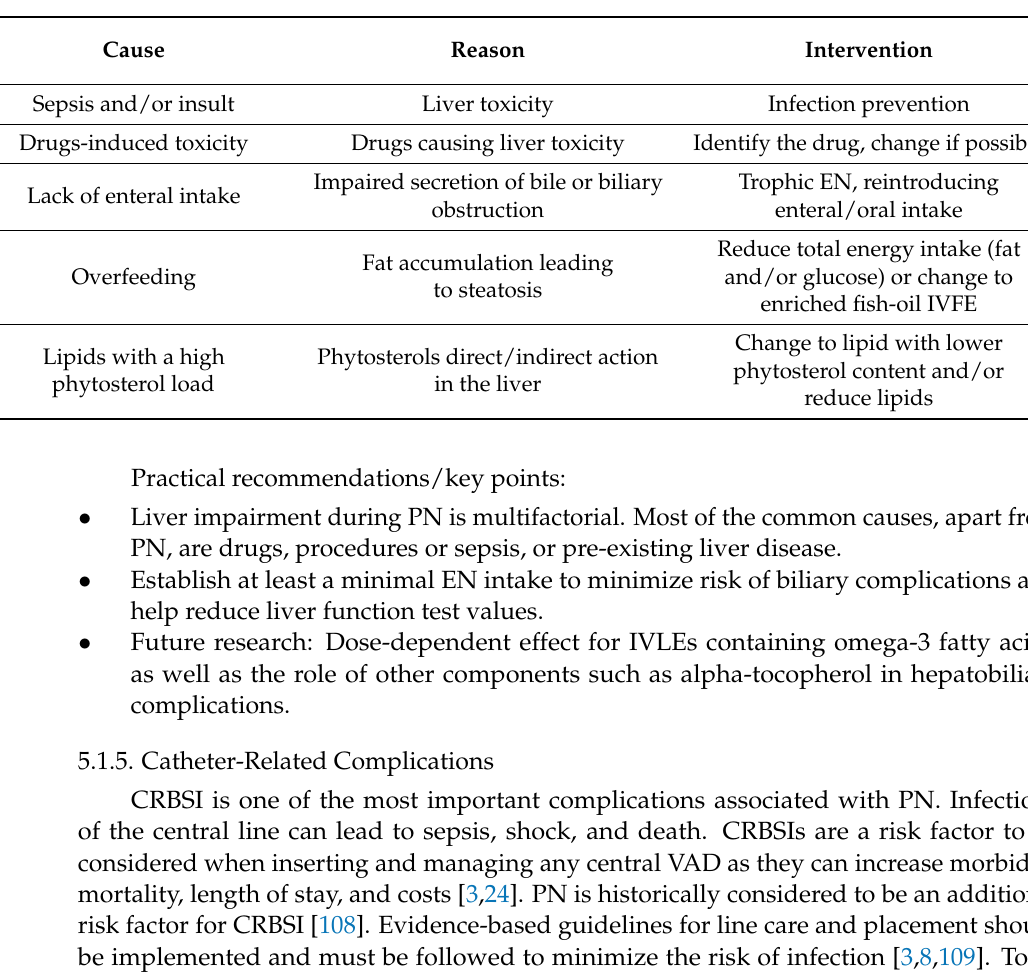
Table 4. Risk factors and interventions to reduce risk for development of